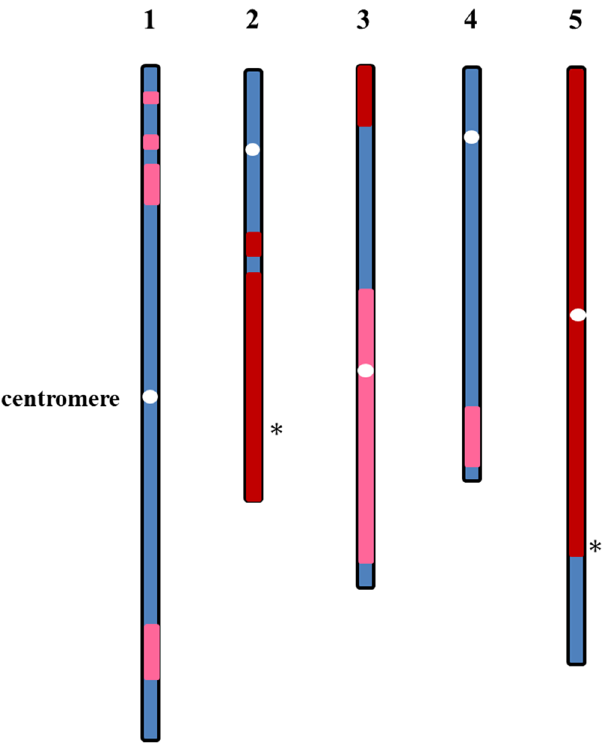
Figure 1. Arabidopsis thaliana sequences present in the 60-day and 300-day-old hybrid cell line. The idiogram shows the regions larger than 200 kb of the Arabidopsis chromosomes that were 60-day present (pink + red), 300-day-old present (red) and absent (blue) in the hybrid cell line. White ovals indicate centromere positions; asterisks (*) indicate fusion positions that join Chr2 and Chr5 in the hybrid genome.